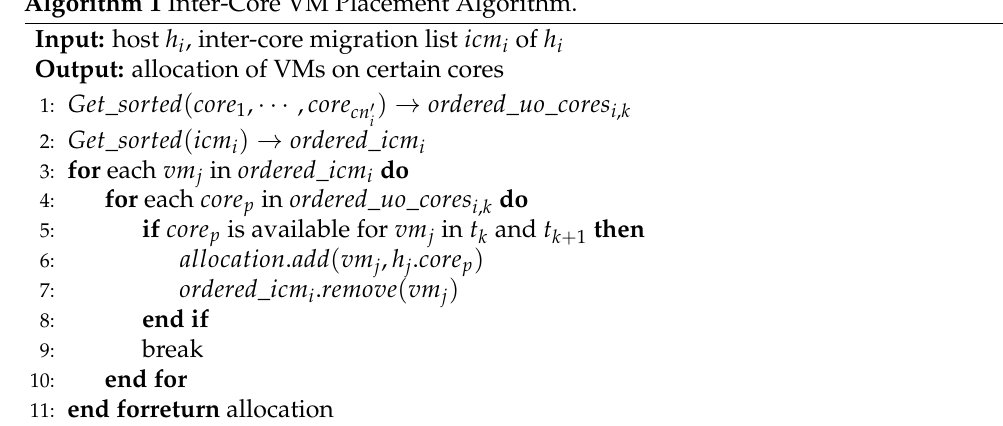
Algorithm 1 Inter-Core VM Placement